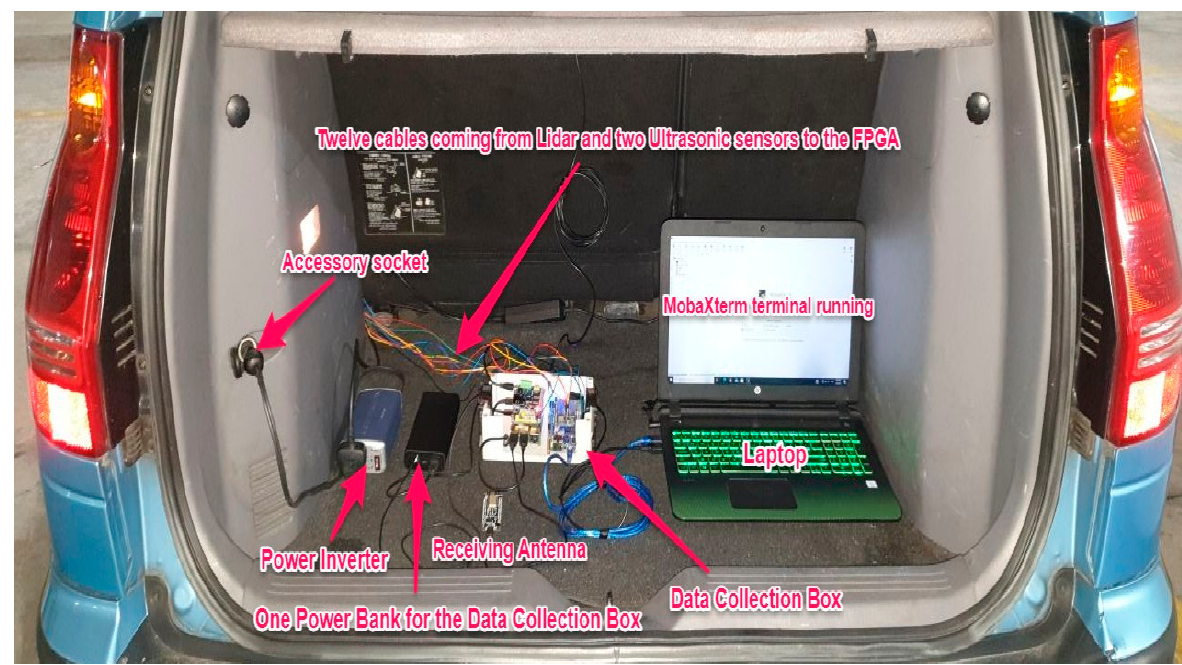
Figure 10. Equipment inside vehicle’s trunk.